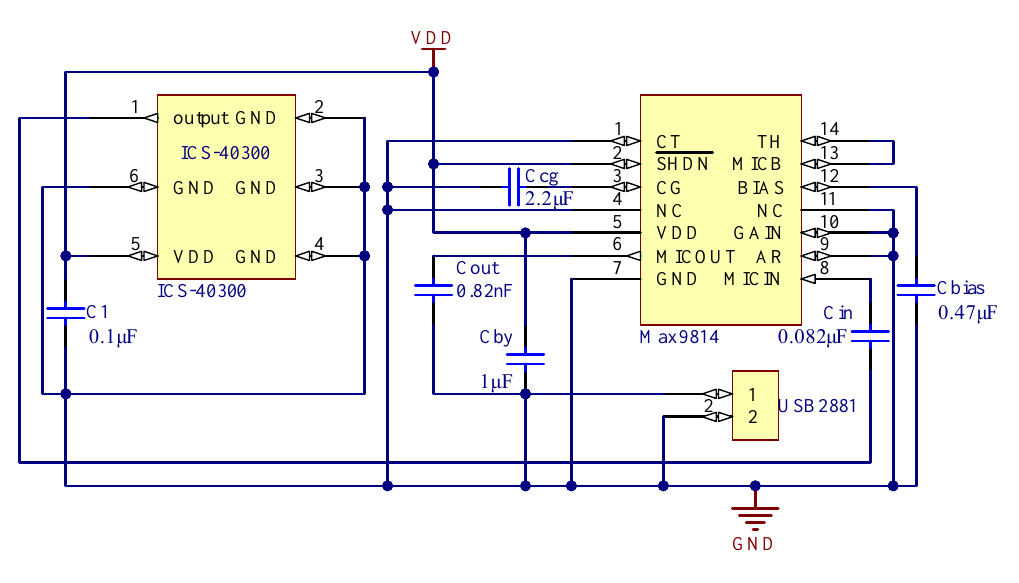
Figure 3. Schematic of the heart sound sensor.